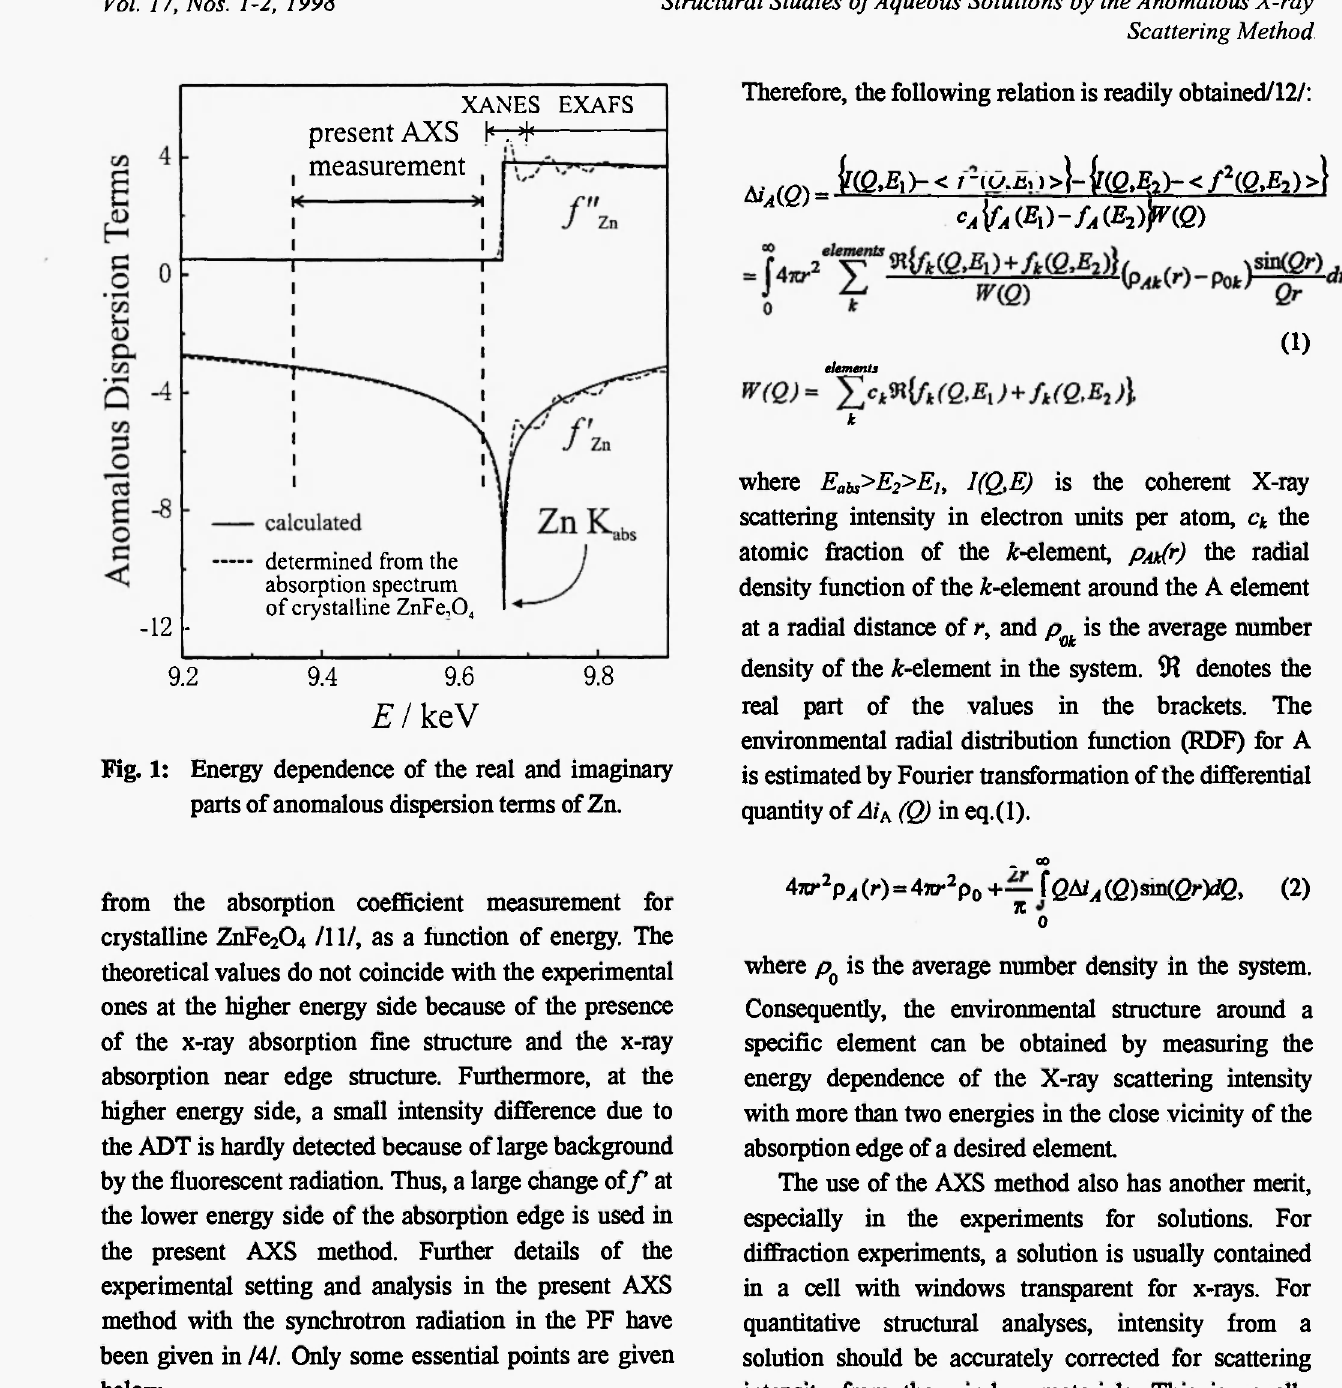
Fig. 1: Energy dependence of the real and imaginary parts of anomalous dispersion terms of